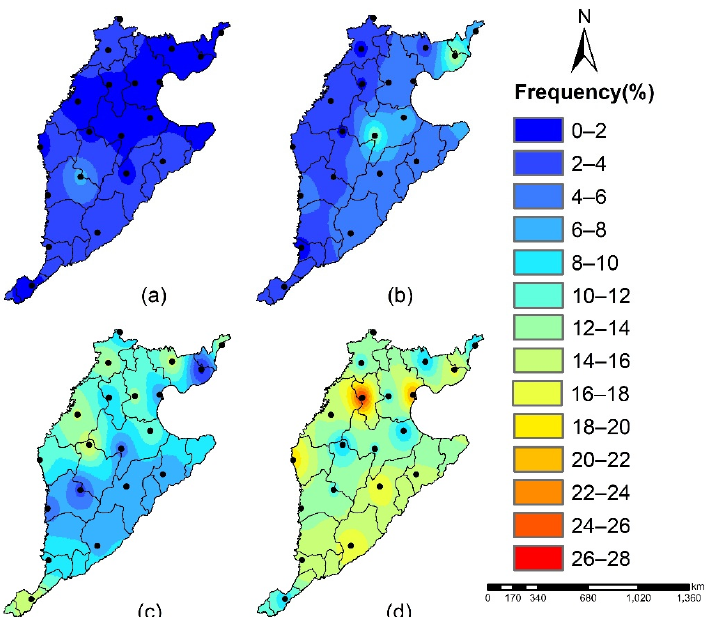
Figure 4. Spatial distribution of ( a ) extreme drought, ( b ) severe drought, ( c ) moderate drought, and ( d ) slight drought frequencies in the Haihe Plain, calculated by annual SPIs.